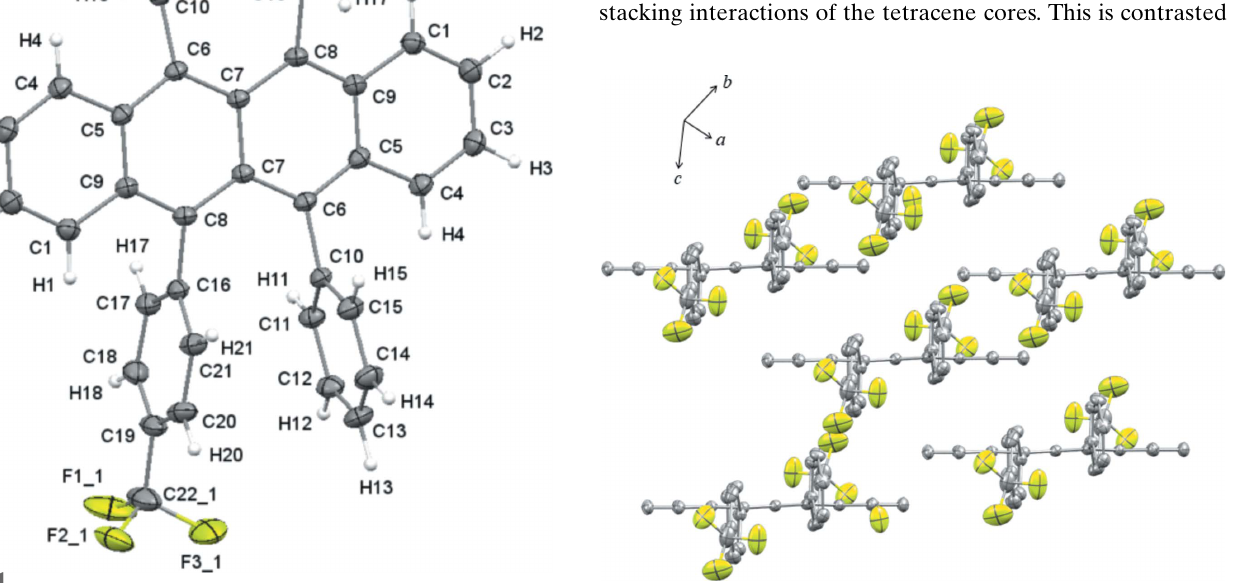
Figure 3 Crystal projection of 1 displaying brick-like